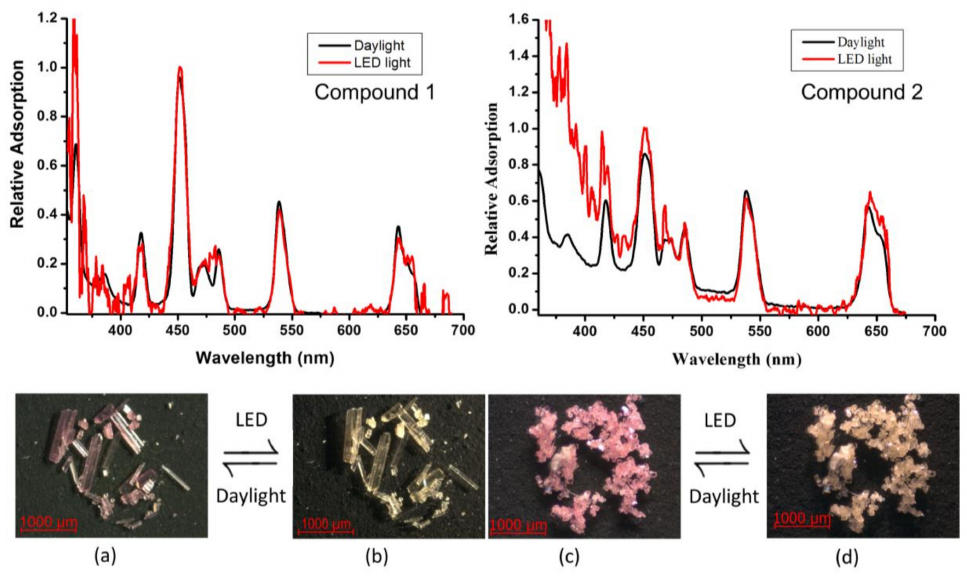
Figure 5. The color-changing images and UV spectra of 1 ( a ) & ( b ) and 2 ( c ) & ( d